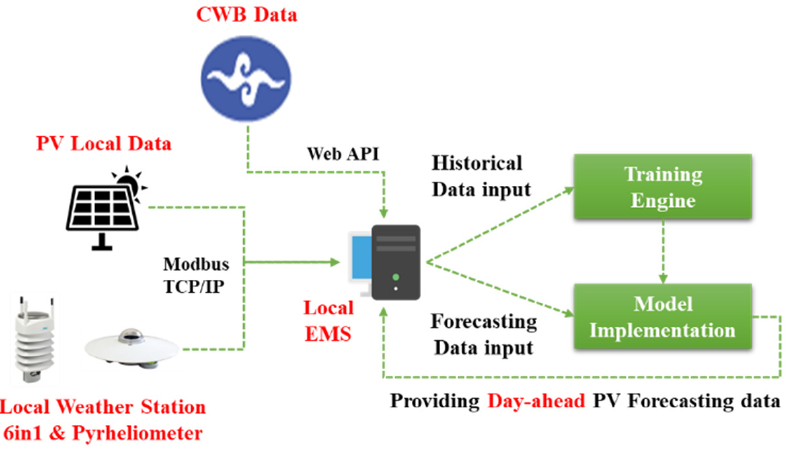
Figure 1. The architecture of data collection (including Central Weather Bureau and local micro weather station) and model forecasting structure.